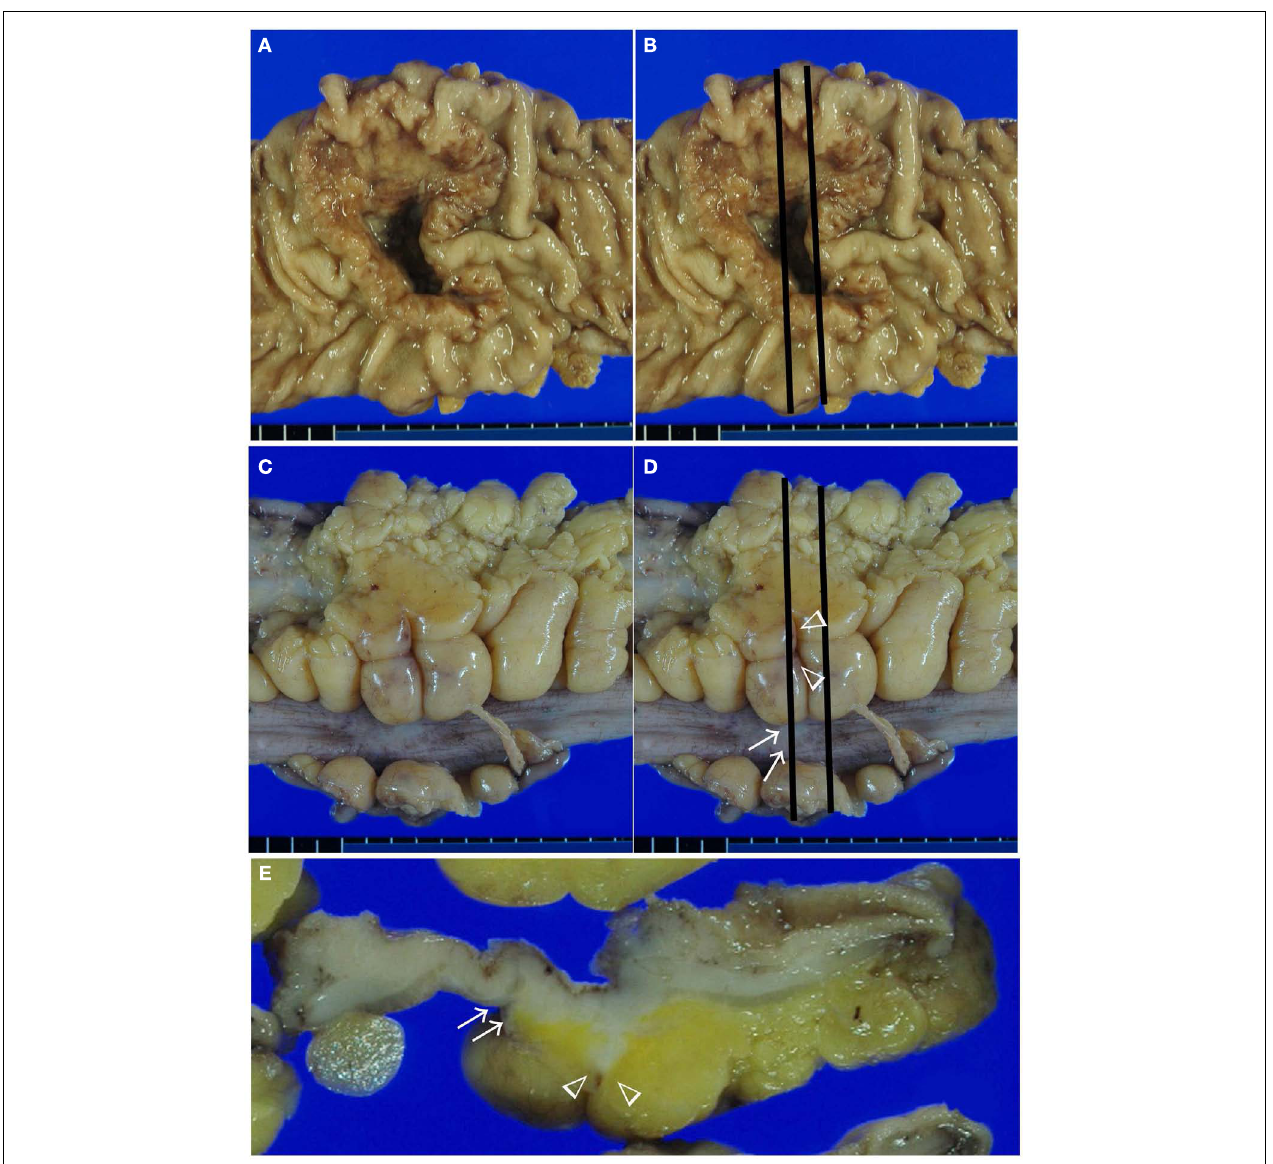
(arrow head) in (D) .The first two slices through these lesions are shown in (B,D) , and the cut surface is shown in (E) . On the cut surface, the indentation of the serosal surface (arrow) and a streak sign (arrow head) were identified. These areas were sampled for histological examination in Figure 2